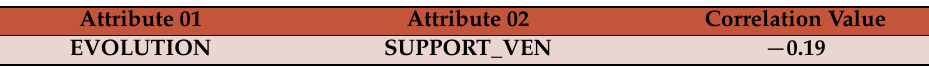
Table 3. Negative